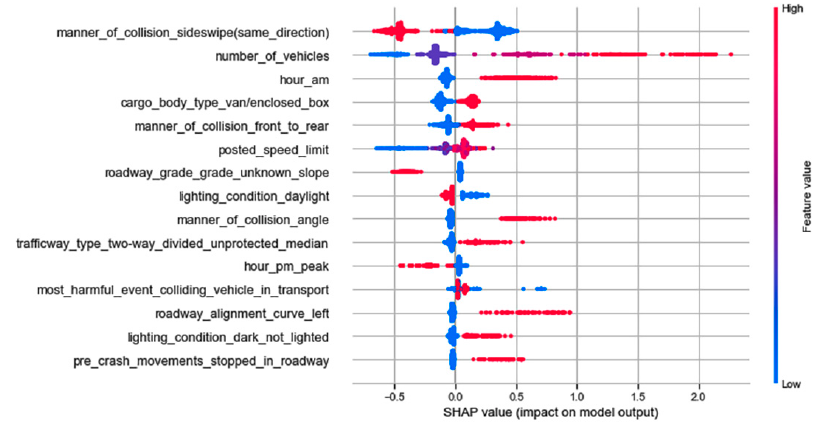
Figure 3. Summary plot for top 15 important features in CL1-based model.